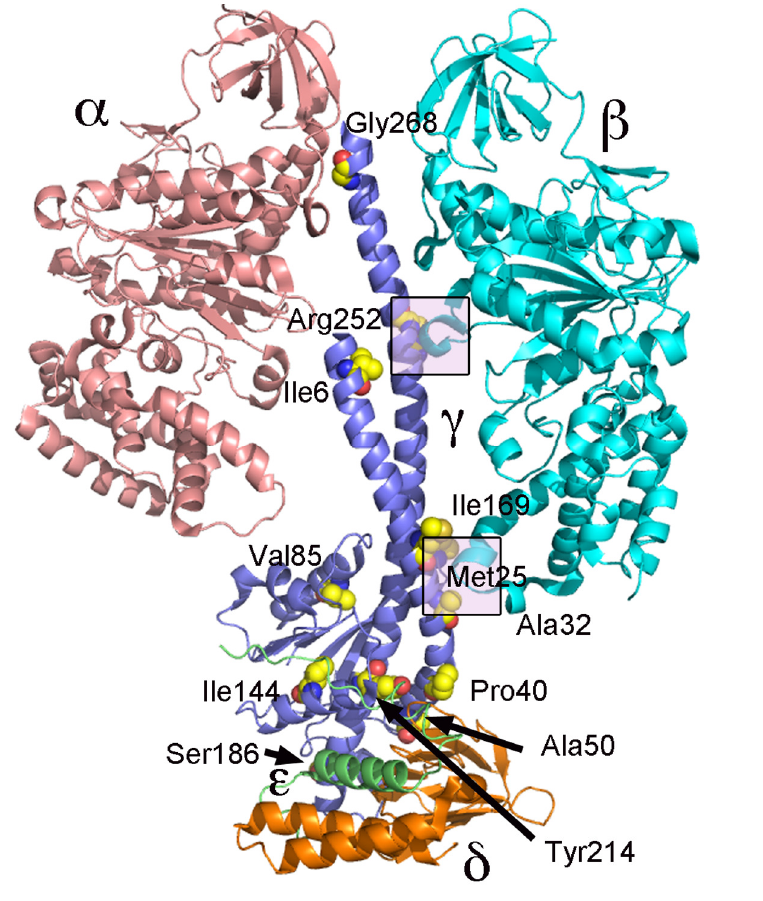
FIGURE 5: Relative location in the ATP synthase of residues mutated by known single nucleotide polymorphisms. The structural representation is derived from the x-ray crystal structure of the bo- vine ATPase (1E79). To simplify the image, only a single copy of the α- (salmon) and β- (cyan) subu- nits is shown along with the γ- (purple), δ- (orange), and ε- (green) subunits. The residues, which are altered by known SNPs in the γ-subunit are shown in sphere representation and numbered using the human numbering system with 1 as the first residue in the mature peptide (the initiating Met is -25 for the γ-subunit). The two boxes represent the regions corresponding to Catch 1 and Catch 2